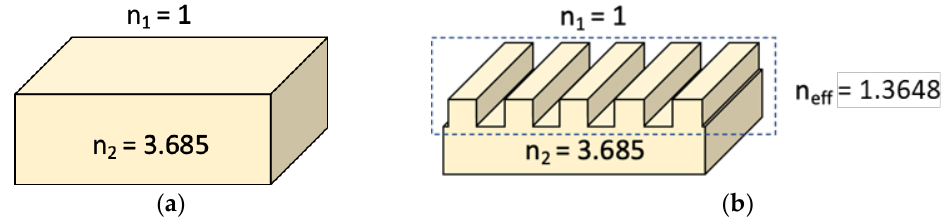
Table 2. The optical properties of a grating PCA and a planar PCA.